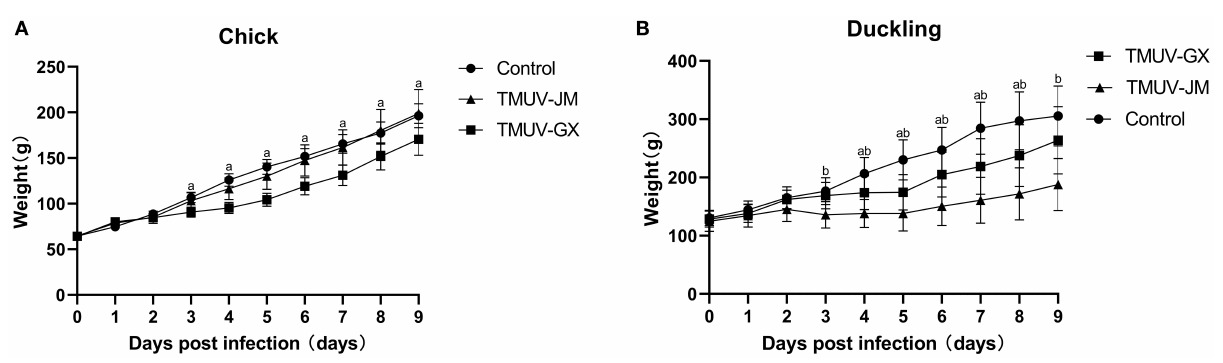
FIGURE3 Weight changes of chicks (A) and ducklings (B) after infection with TMUV. The error bars indicate the means ± standard deviation (SD). Different lowercase letters over the bars denote statistically significant differences ( p < 0.05) between the infection groups and the control group